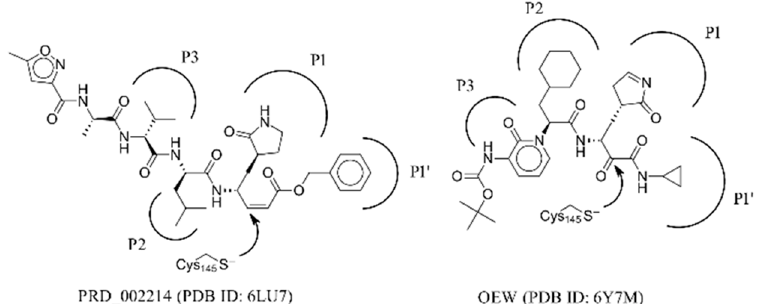
Figure 1. Existing inhibitors of SARS-CoV-2 supported by structural data. Depicted are binding pockets (Px) and the site of covalent